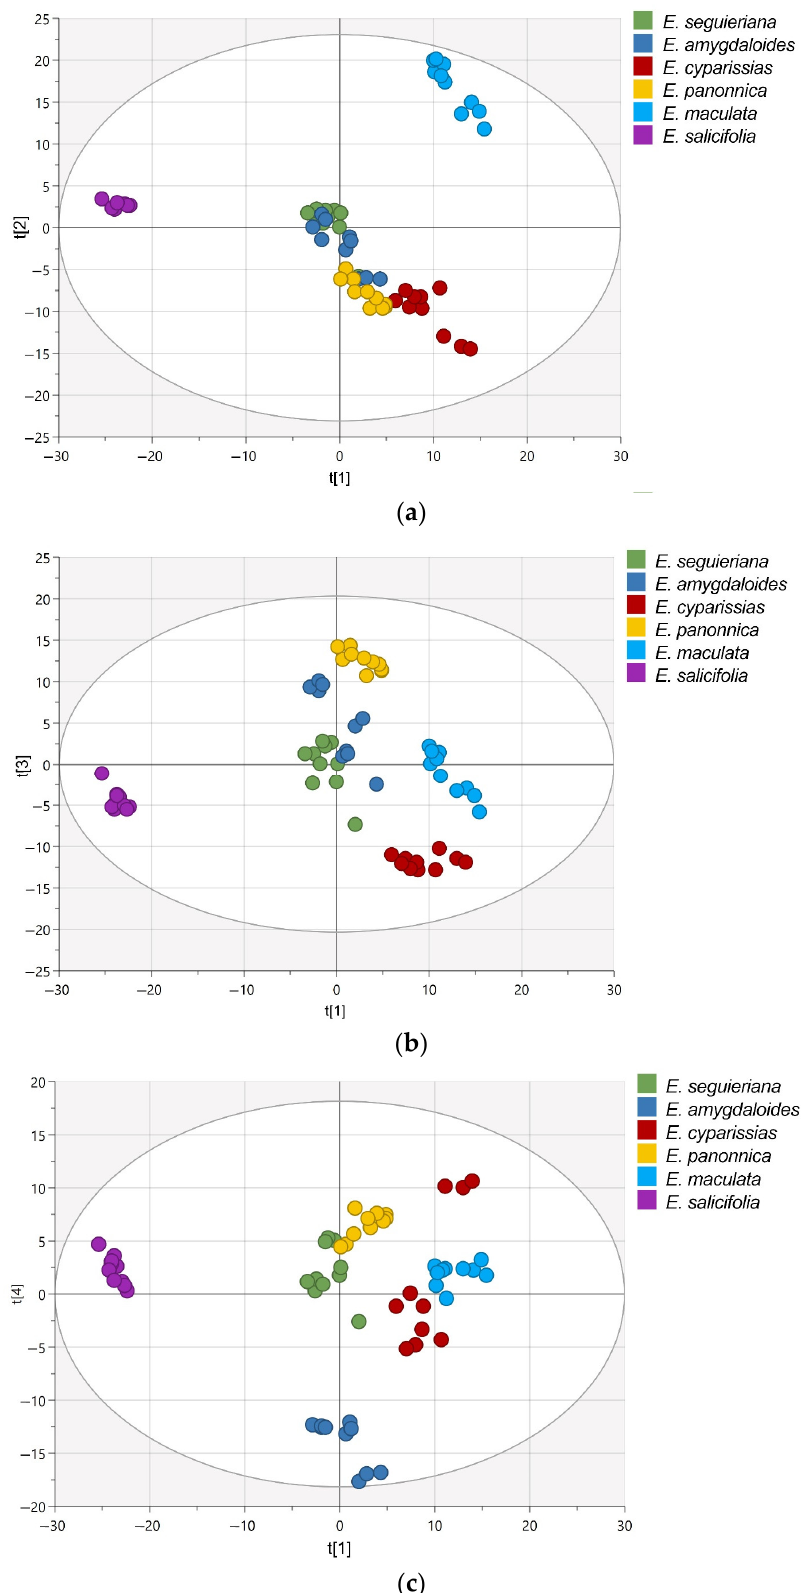
Figure 2. PCA score plots: PC1/PC2 ( a ), PC1/PC3 ( b ), and PC1/PC4 ( c ). Scores are colored in accordance with Euphorbia species.